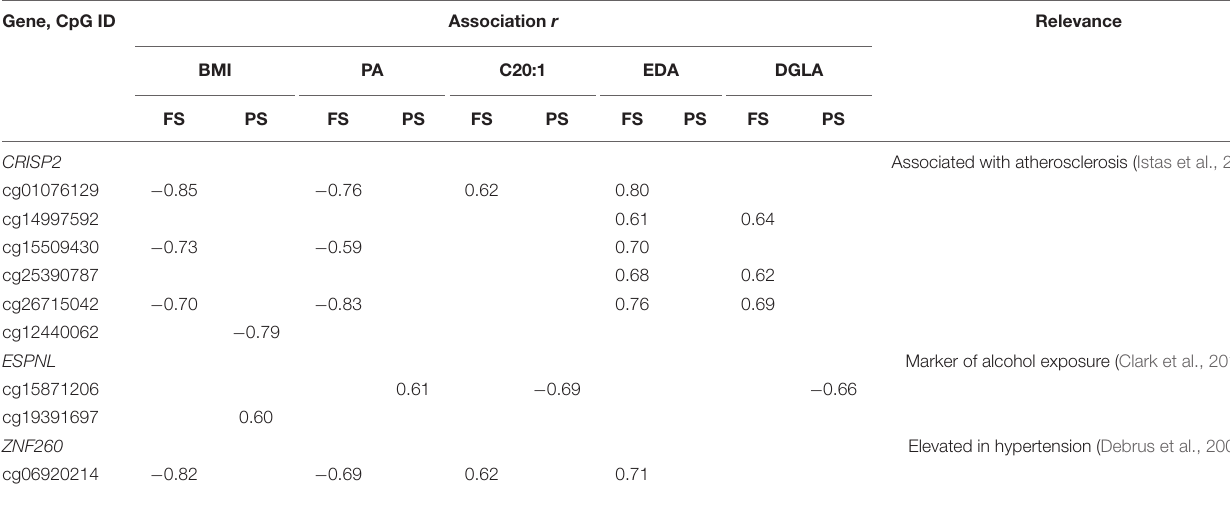
TABLE 3 | Promoter dmCpG associated with BMI and